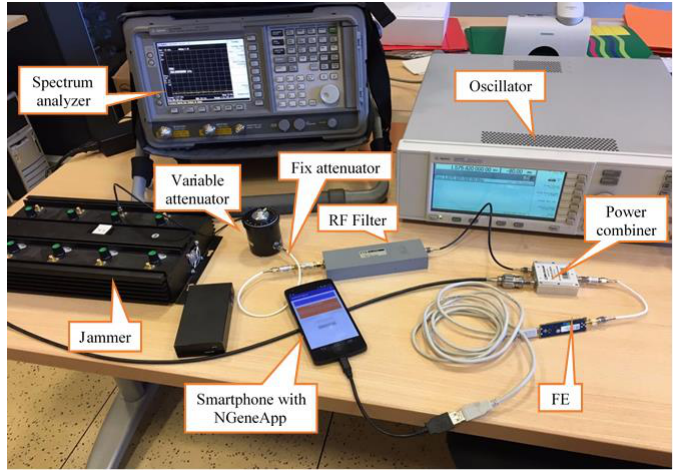
Figure 3. In-laboratory test setup.